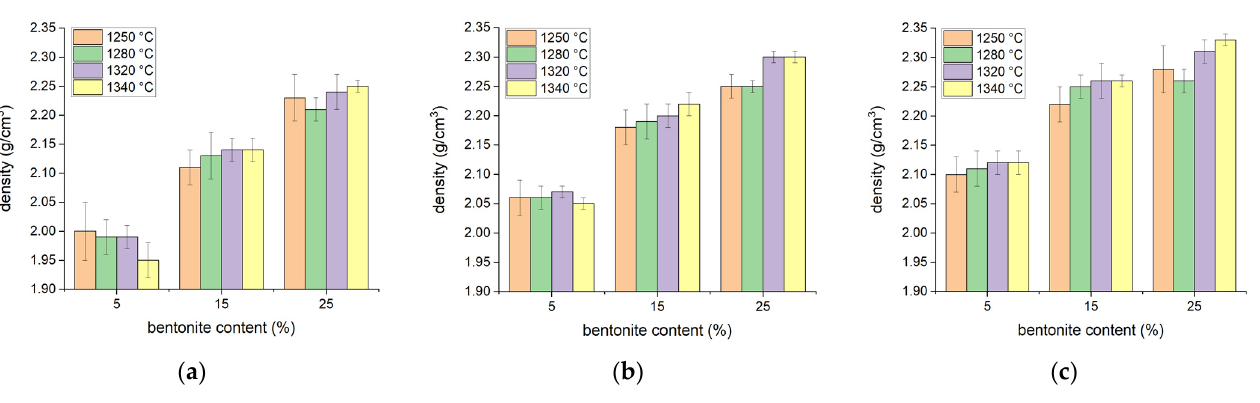
with the use of HAM as a filler appeared similar to that in materials based on F240: the